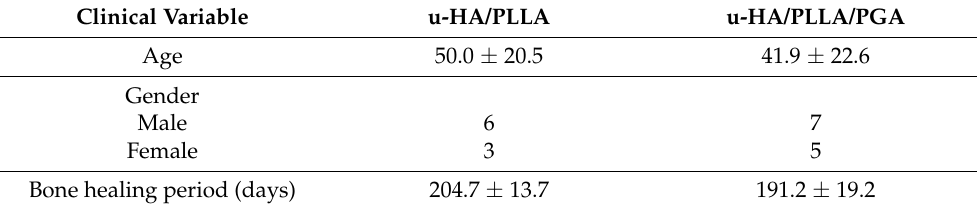
Table 1. Patient distribution for alveolar bone augmentation in both groups. Clinical